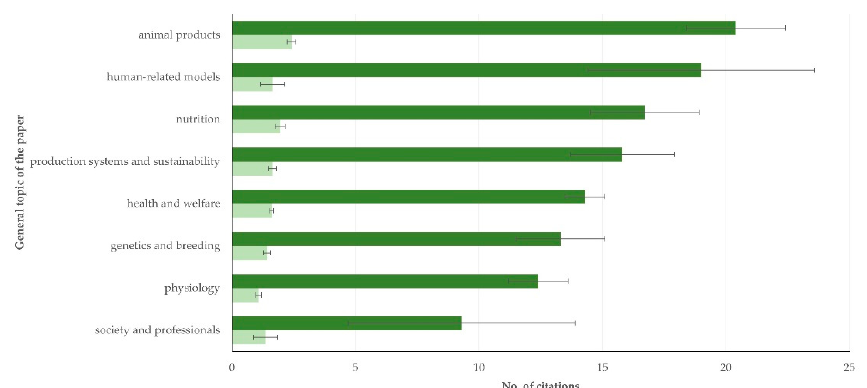
Figure 4. Mean no. of citations (dark green: average total number, light green: average yearly number) received by papers on sheep and goats published during 1997–2022 from Greece, in accord with the general topic of the papers (bars indicate standard error of the mean).